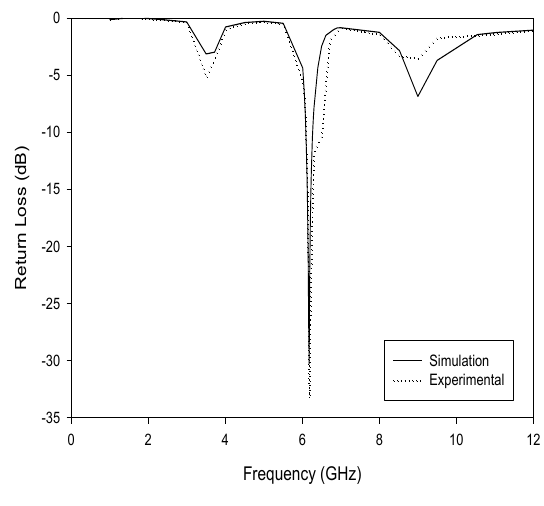
Figure 3. Simulation and Experimental variation of Return loss with frequency (without defect).